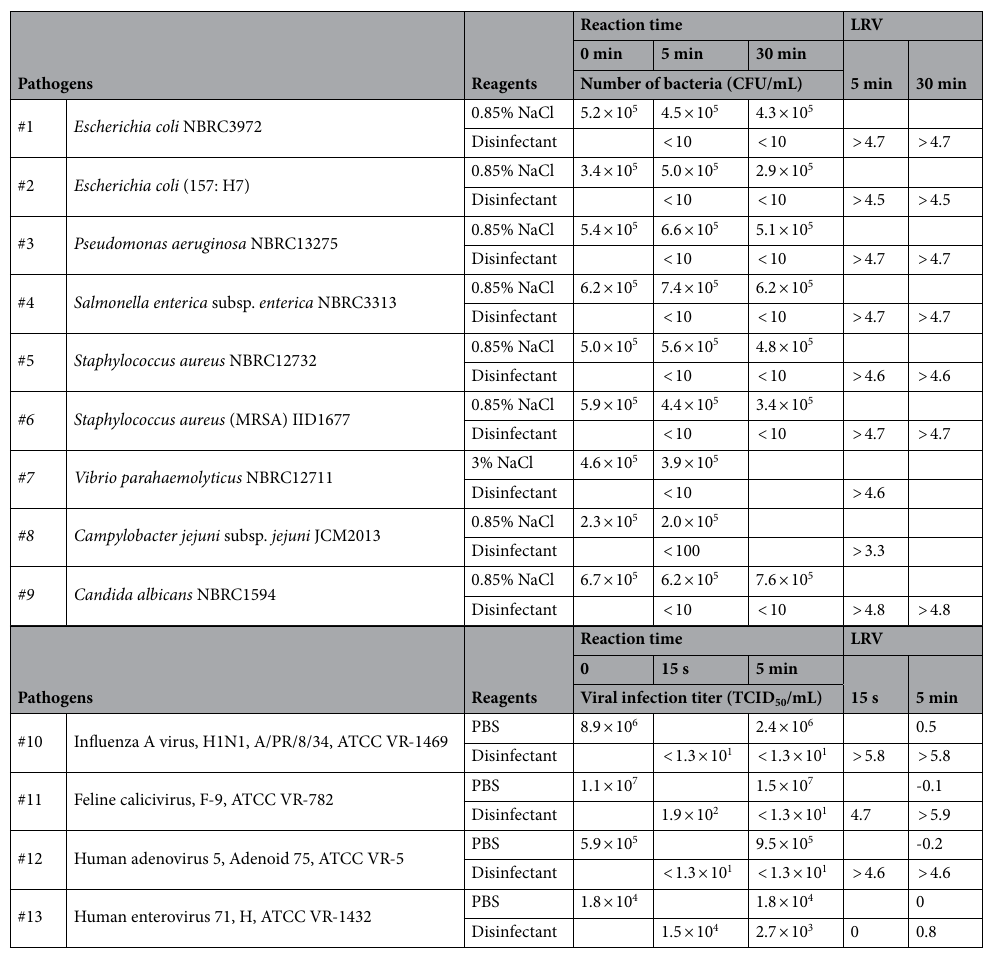
Table 1. Time taken to completely inactivate microorganisms following contact with the disinfectant. CFU/ mL colony-forming units per milliliter, lower limit of quantification 10 CFU/mL (except for Campylobacter , with a lower limit of quantification of 100 CFU/mL), min minutes, LRV log reduction value, TCID 50 /mL 50% tissue culture infectious